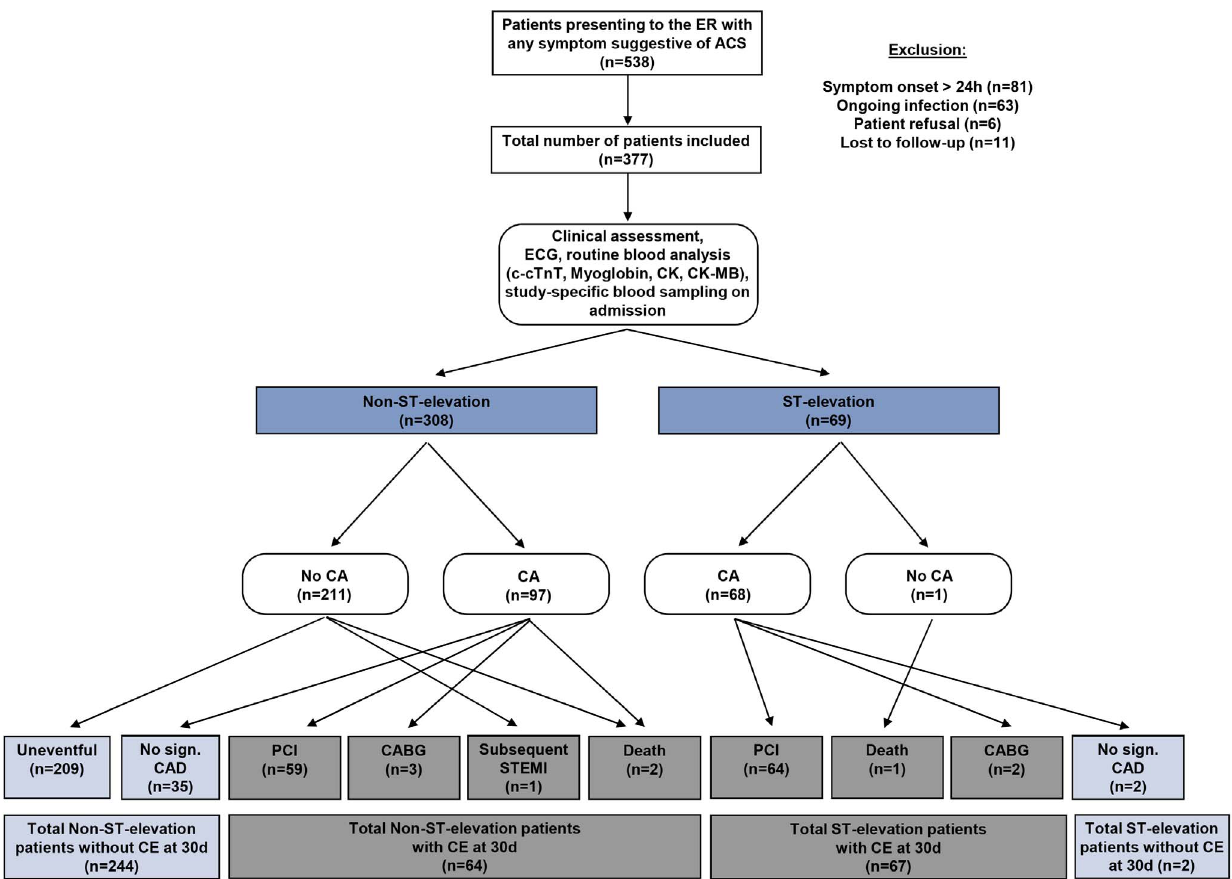
Figure 1. Study flow chart of the prospective, observational MyRiAD study. Abbreviations: ER, emergency room; CA, coronary angiography; CAD, coronary artery disease; CE, cardiac events (composite of early coronary revascularization by percutaneous coronary intervention [PCI] or coronary artery bypass grafting [CABG], subsequent myocardial infarction or cardiovascular death); c-cTnT, conventional cardiac troponin T; CK, creatine kinase; CK-MB, creatine kinase-myocardial band.